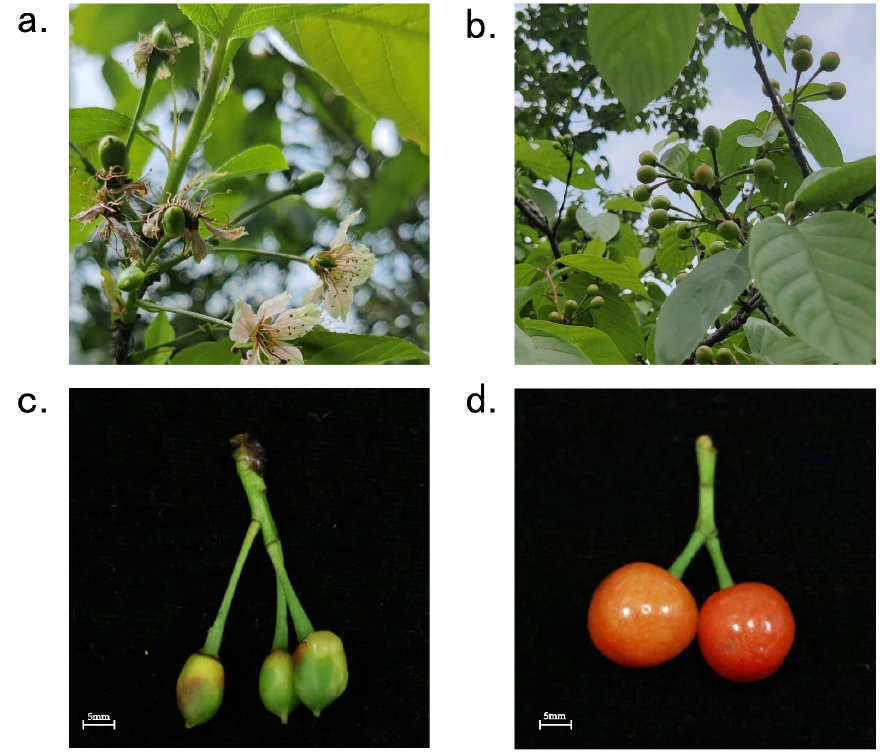
Figure 1. ( a ): Stiff fruit in the tree show abnormal shape and stagnant development. ( b ): Healthy fruit in the tree show spherical shape and well-development. ( c ): Stiff fruit fail to mature and keep abnormal shape when healthy fruit is ripe. ( d ): Ripe healthy fruit show red color and spherical shape.